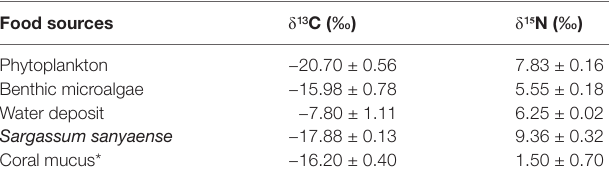
TABLE 7 | The isotopic composition of potential food sources of Stichopus monotuberculatus (n = 3). Food sources